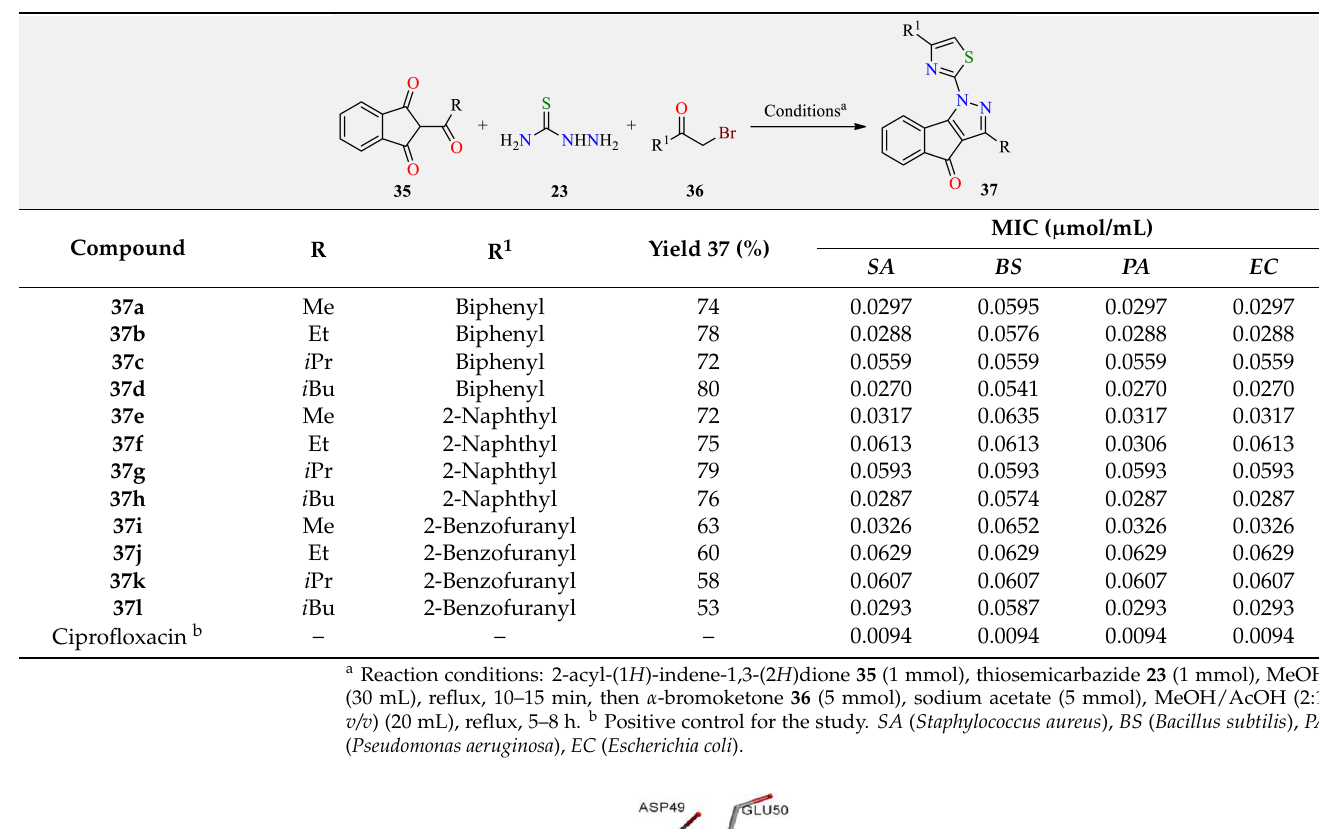
Table 8. One-pot three-component synthesis of 3-alkyl-1-(4-(aryl/heteroaryl)thiazol-2- yl)indeno[1,2- c ]pyrazol-4(1 H )-ones 37 as antibacterial agents.